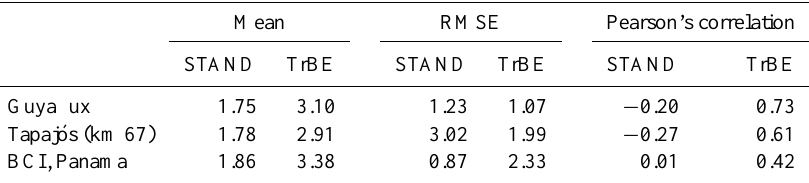
Table 2. Goodness of fit evaluation statistics for standard (STAND) and modified ORCHIDEE (TrBE) modelled leaf litterfall